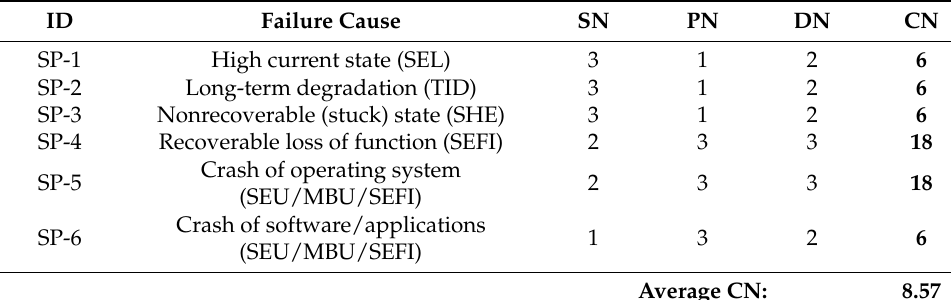
Table 9. Criticality determination for the signal-processing device